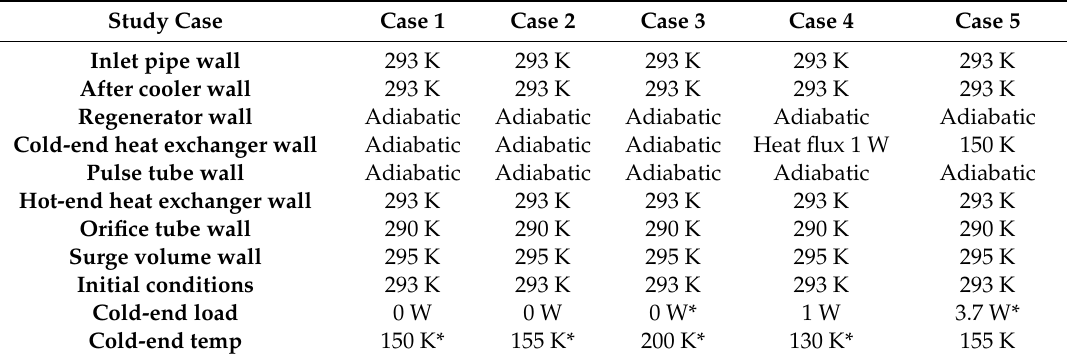
Table 1. Boundary conditions for cases 1–5.